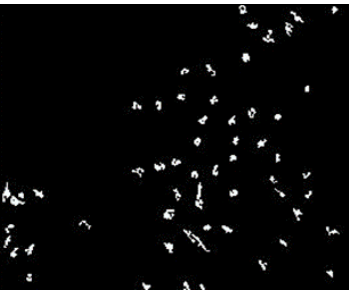
Figure 5. Morphological Operation Result